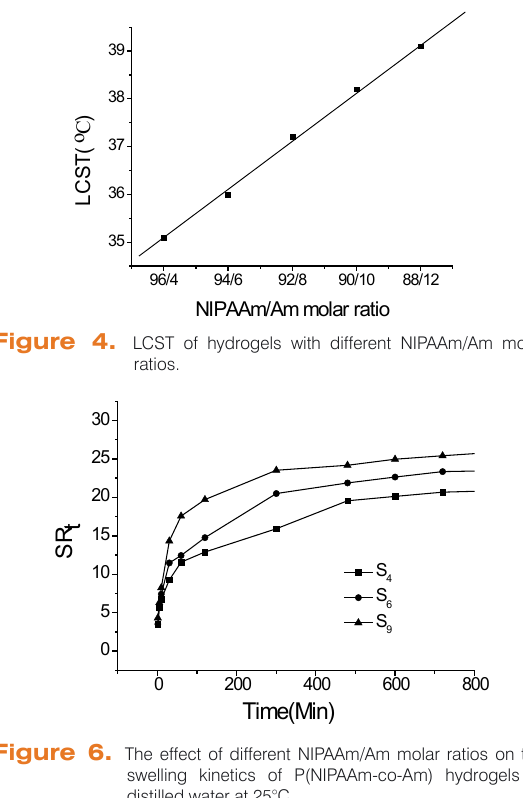
Figure 6. The effect of different NIPAAm/Am molar ratios on the swelling kinetics of P(NIPAAm-co-Am) hydrogels in distilled water at